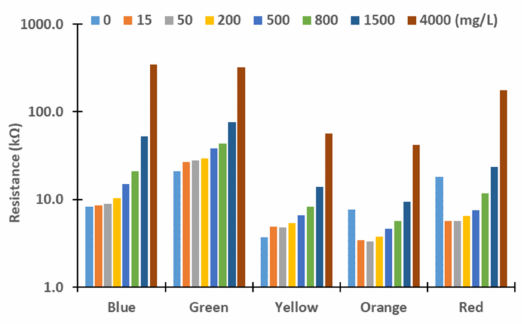
Figure 7. Measured resistance values for mixture 60% sediment and 40% algae.